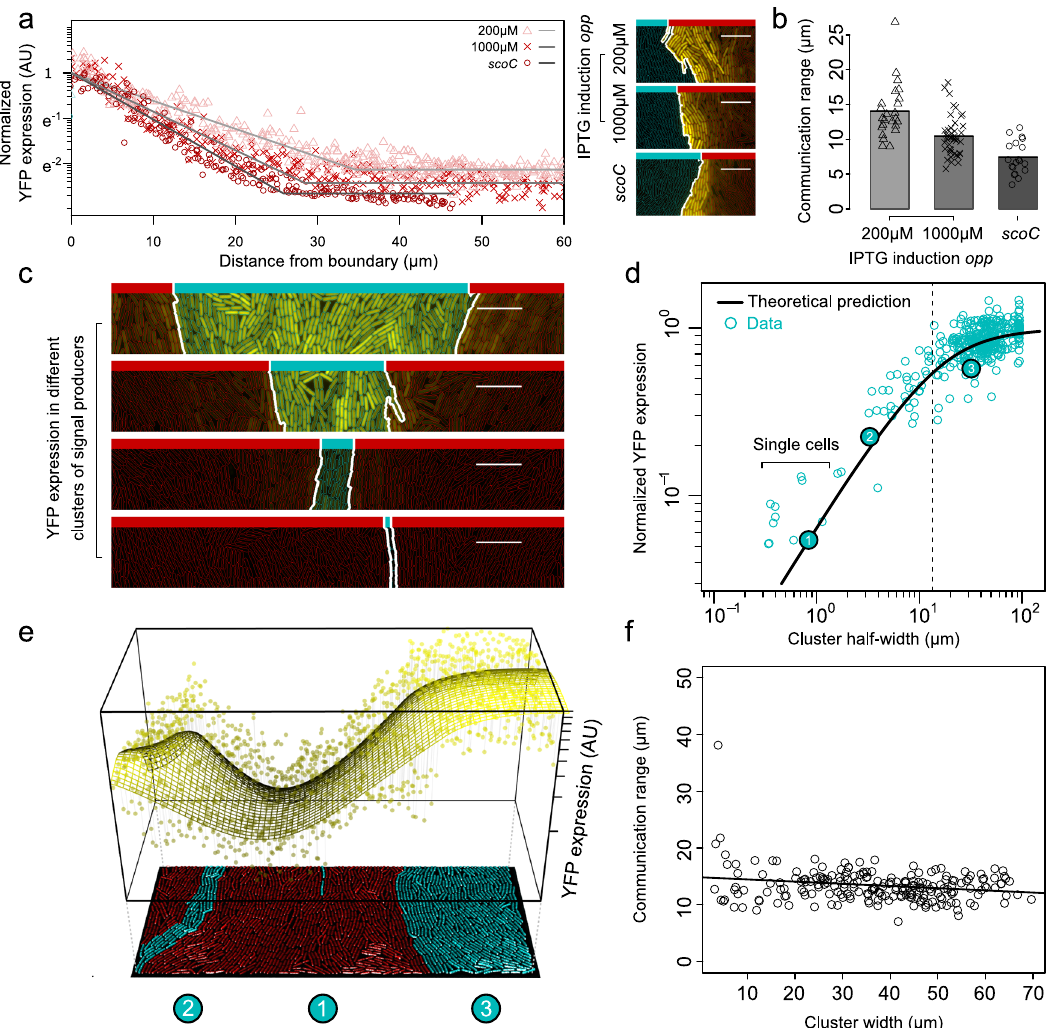
Fig. 3 Signal uptake leads to a shorter communication range in absorbing PlcR-PapR system. a Normalized YFP expression in signal receivers as a function of their distance to the producers in IPTG-inducible opp system and scoC knockout mutant (right, representative microscopy images). Signal producers in ( a ) do not express YFP. Gray lines show best fi ts (see “ Methods ” ). b Communication range decreases for higher IPTG concentrations in the IPTG-inducible opp system ( U ¼ 825 ; p ¼ 2 : 7 ´ 10 (cid:3) 5 ) and decreases even further in the scoC knockout ( U ¼ 648 ; p ¼ 1 : 5 ´ 10 (cid:3) 4 ) (200 μ M IPTG, n ¼ 24; 1000 μ M IPTG, n ¼ 43; scoC , n ¼ 19; statistics show two-sided Mann – Whitney U tests without adjustments for multiple comparisons). c Representative microscopy images of differently sized clusters of signal producers. d Normalized YFP expression in isolated clusters of signal producers as a function of their half-width (blue dots), observed YFP expression ( n ¼ 362 chambers). YFP levels are normalized to their maximal levels; black line, theoretical prediction based on the measured communication range (see “ Methods ” ); vertical dashed line, the communication range of PlcR-PapR system. Enlarged data points 1 – 3 correspond to three co-occurring clusters of signal producers visualized in ( e ). e Observed (dots) and predicted (grid surface) YFP expression in chamber with three co-occurring clusters of signal-producing cells. f Communication range as a function of the cluster size for clusters wider than 3 μ m (linear regression: intersect = 14 : 8 ± 0 : 5 μ m ð s : e : Þ , slope = (cid:3) 0 : 04 ± 0 : 01 μ m, p ¼ 0 : 0014 ; n ¼ 213 chambers). Microscopy images: blue bars = region of signal producers; red bars = region of signal receivers; yellow = signal response; scale bar = 10 μ M. Source data are provided in Supplementary Data